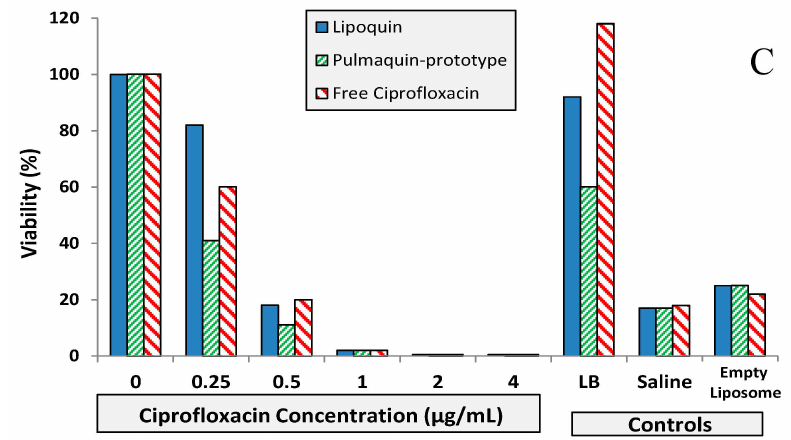
Figure 9. BIC assay results for Lipoquin, Pulmaquin-prototype and free ciprofloxacin formulations in ( A ) CF sputum isolate (Strain #26), ( B ) ventilator-associated pneumonia endotracheal aspirate isolate (Strain #19), and ( C ) CF sputum isolate (Strain #57a). Controls include LB cell medium, saline and empty liposomes. Results show the mean viability of biofilm of two separate experiments based on OD readings made in triplicate for each experiment. The mean OD value for each formulation was compared to that of the LB medium control to determine the percent reduction in biofilm biomass